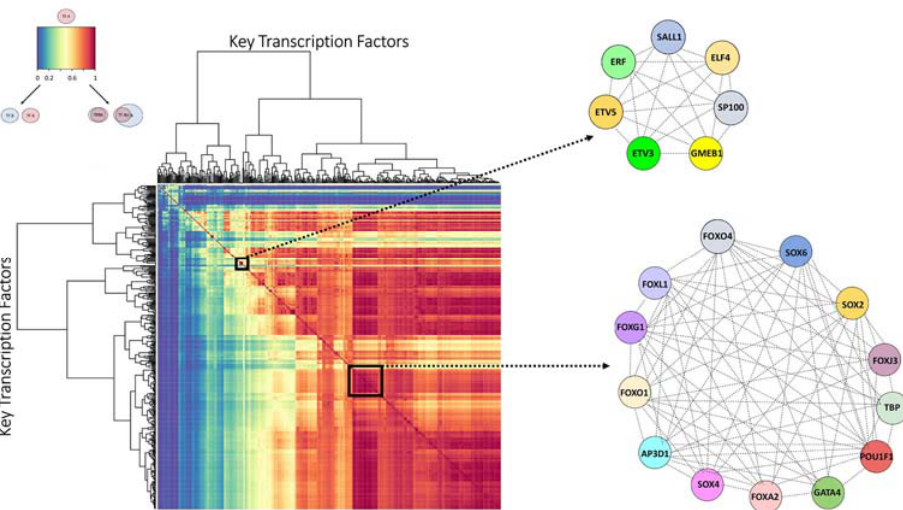
Figure 4. The identification of TFCGs in the high impact group network. The heatmap displays the hierarchical clustering of putative gene target percentage overlap of one Key TF as compared to all others. The dark blue to dark red color gradient denotes the degree of shared target overlap. Because the degree of target overlap between a pair of Key TFs may be non-reciprocal, the dendrograms are ordered based on mutual relationships and are oriented identically on the x- and y-axis. The diagonal represents a Key TF compared to itself. Only reciprocal relationships between groups of Key TFs were considered TFCGs (white boxes demarcate two representative TFCGs as symmetrical squares on the diagonal). Beside the heatmap are two representative TFCG schematics depicting a TFCG containing Key TFs that reciprocally share >70% of their predicted target genes with each other.